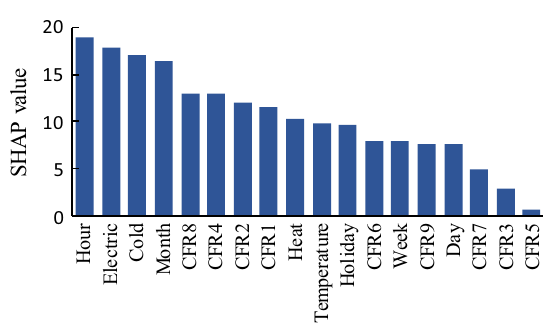
Fig. 11 Weighted SHAP values of feature